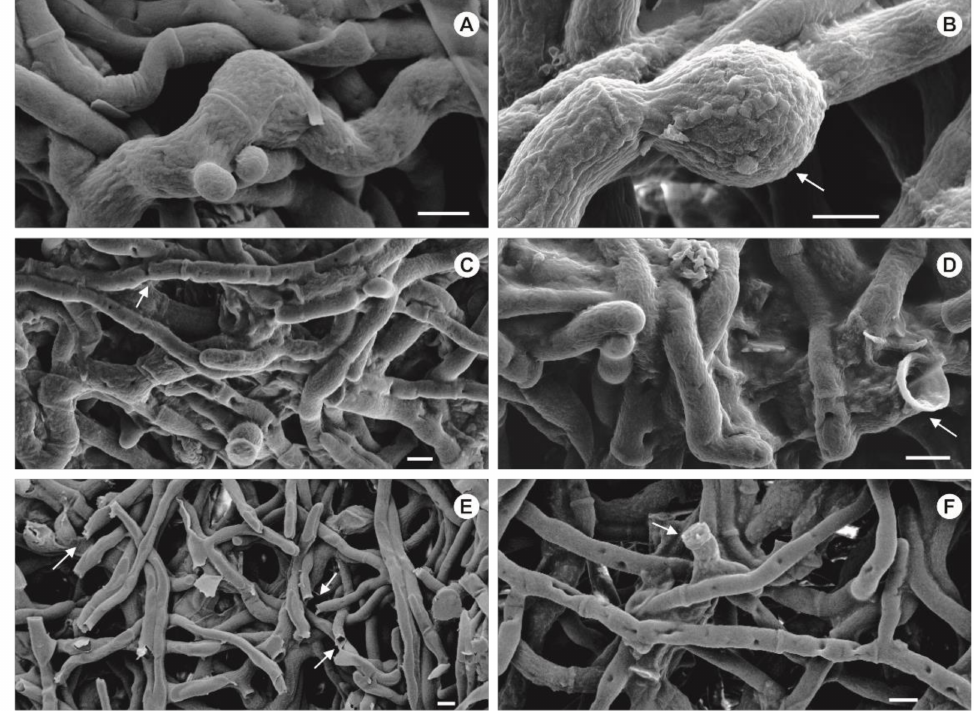
Figure 6. SEM photographs of Penicillium sizovae . ( A , B ) Hyphal cells and chlamydospore (white arrow) formed in a liquid medium; ( C , D ) disruption of hyphae (white arrow) subjected to mechanical extraction by maceration with mortar and pestle; ( E , F ) disruption of hyphae (white arrows) and a greater number of holes in the mycelium submitted to physical maceration by sonication. Bars ( A – F ) = 2 µ